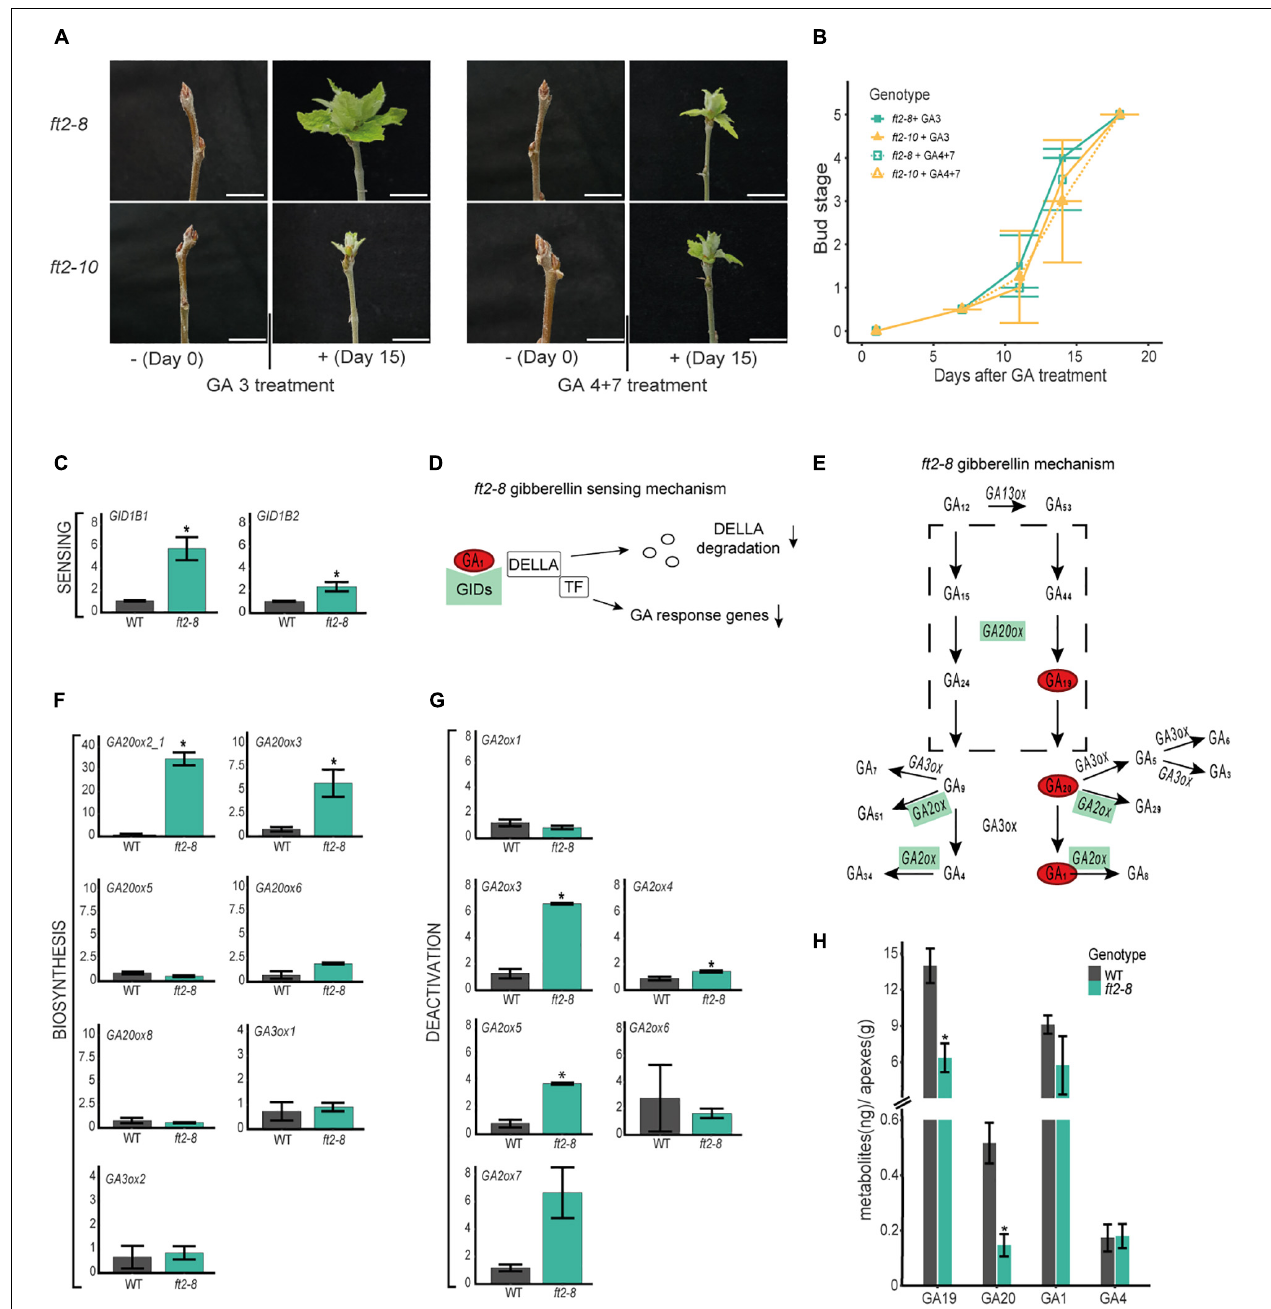
FIGURE 3 | FT2 promotes the gibberellin (GA) biosynthesis 13-hydroxylation pathway branch in the shoot apex. (A) Images of apical buds of WT, ft2-8, and ft2-10 lines treated with 0 µ M and 10 µ M of GA 3 or GA 4 + 7. Pictures were taken on Day 0 and Day 15 of GA treatment. Scale bar = 2 cm. (B) Line plot showing bud scores for WT, ft2-8, and ft2-10 plants collected weekly from Day 0 of GA treatment until buds reached stage 5. (C) Bar plot showing relative mRNA levels of GA sensing genes GID1B1 and GID1B2 in ft2-8 and WT shoot apex. (D) Schematic representation of the GA-GIDs-DELLA molecular model (Nelson and Steber, 2018). High GID expression and lower GA 1 levels might reduce GA responses in the shoot apex. (E) Schematic representation of GA metabolism. Green rectangle denotes genes found upregulated in ft-8 compared to WT shoot apex. Red oval shows precursor and bioactive GA found at lower levels in ft-8 than WT shoot apex. (F,G) Bar plot showing relative mRNA levels in ft2-8 and WT shoot apex of (F) the GA biosynthesis genes GA20ox and GA3ox, and (G) GA deactivated genes GA2ox . (H) Bar plot showing the quantification of precursors and bioactive GA in WT and ft2-8 shoot apex. The Y-axis scale shows metabolites (ng)/apex (g), and the X-axis indicates the precursor or bioactive GA measured, that is, GA 19 , GA 20 , GA 1 , or GA 4 . (C,F,G) Plotted values and error bars are fold-change means ± SD recorded in two biological replicates. Ubiquitin7 was used as the housekeeping gene. Asterisks (*) represent significant differences between genotypes assessed by one-way ANOVA ( p <